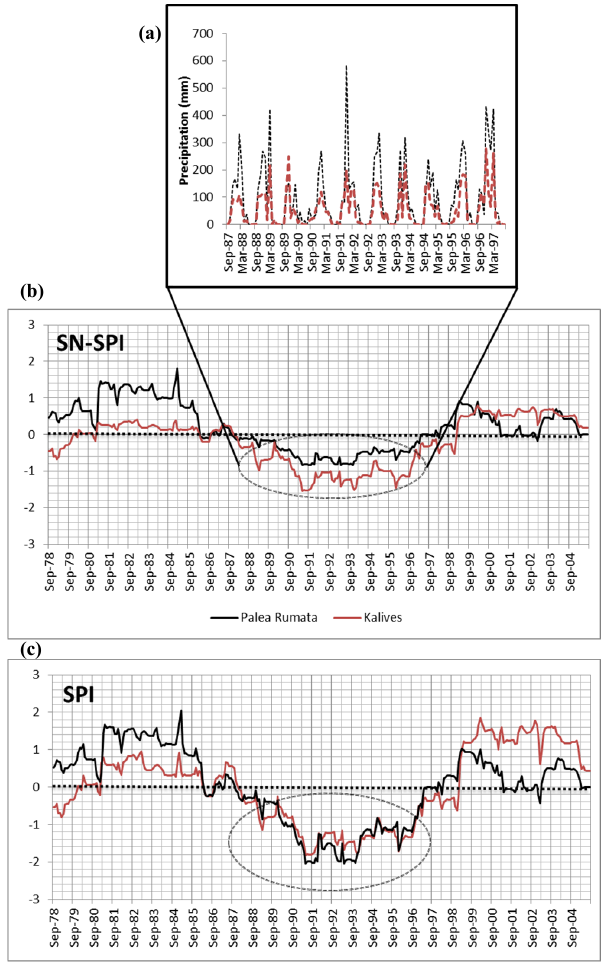
Fig. 5. (a) Monthly precipitation time series for drought events (b) 48-month time scale SN-SPI and (c) SPI for two representative stations of south-central Crete based on the period